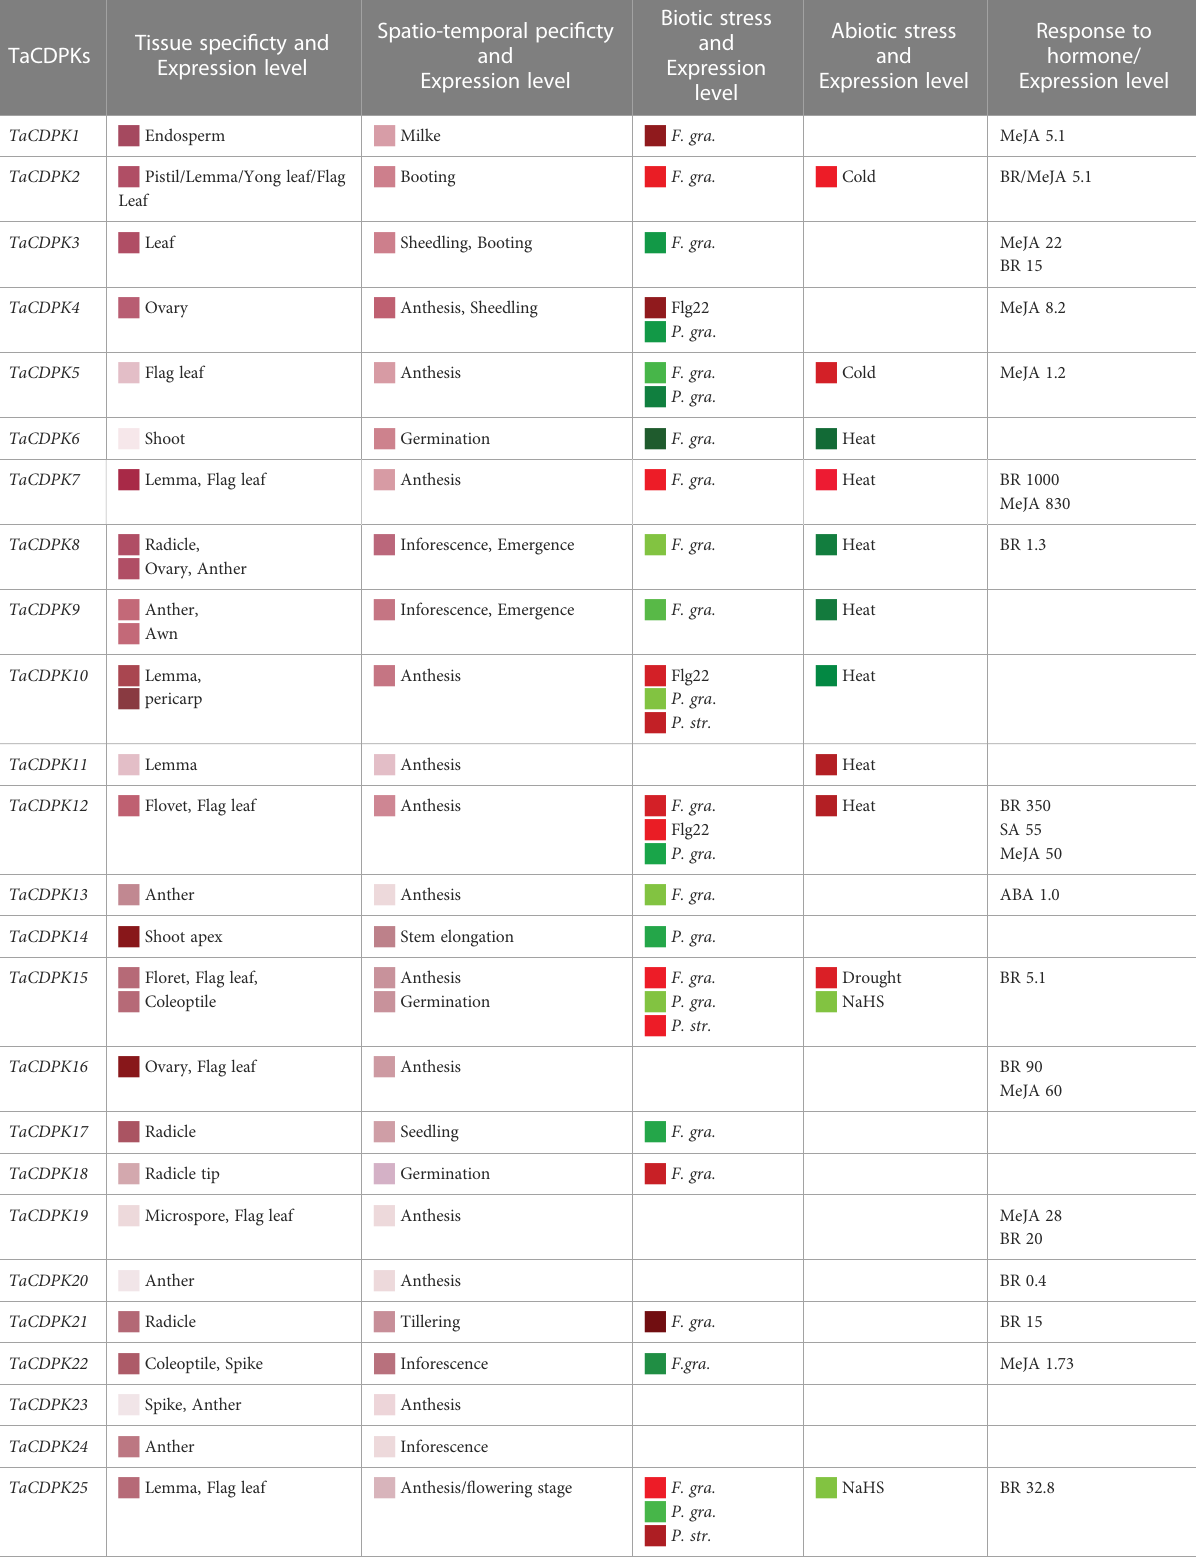
TABLE 1 Expression speci fi city and functional diversity of TaCDPKs in wheat.